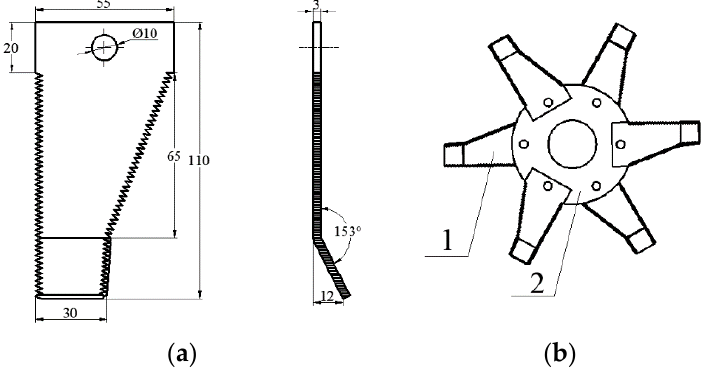
Figure 4. Structure and distribution of vine killers. ( a ) Improving the structure of L-type vine killing knife. ( b ) Distribution of vine killers: 1. vine killing knife; 2. cutter head.